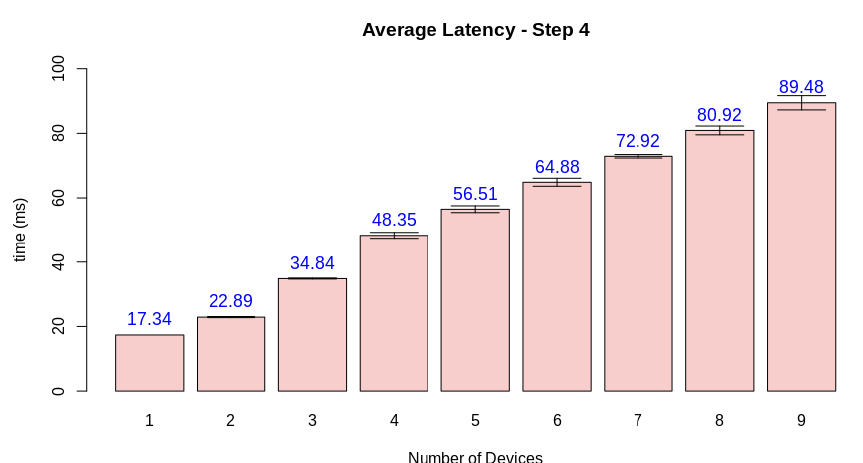
Figure 28. Latency test results for step 3.